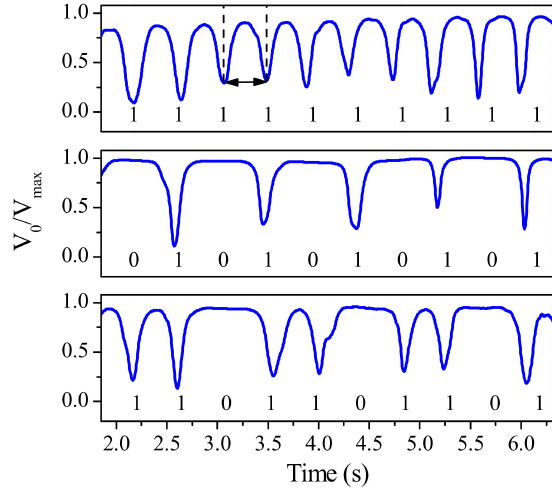
Figure 14. Normalized measured envelope functions of the indicated codes. Figure extracted from